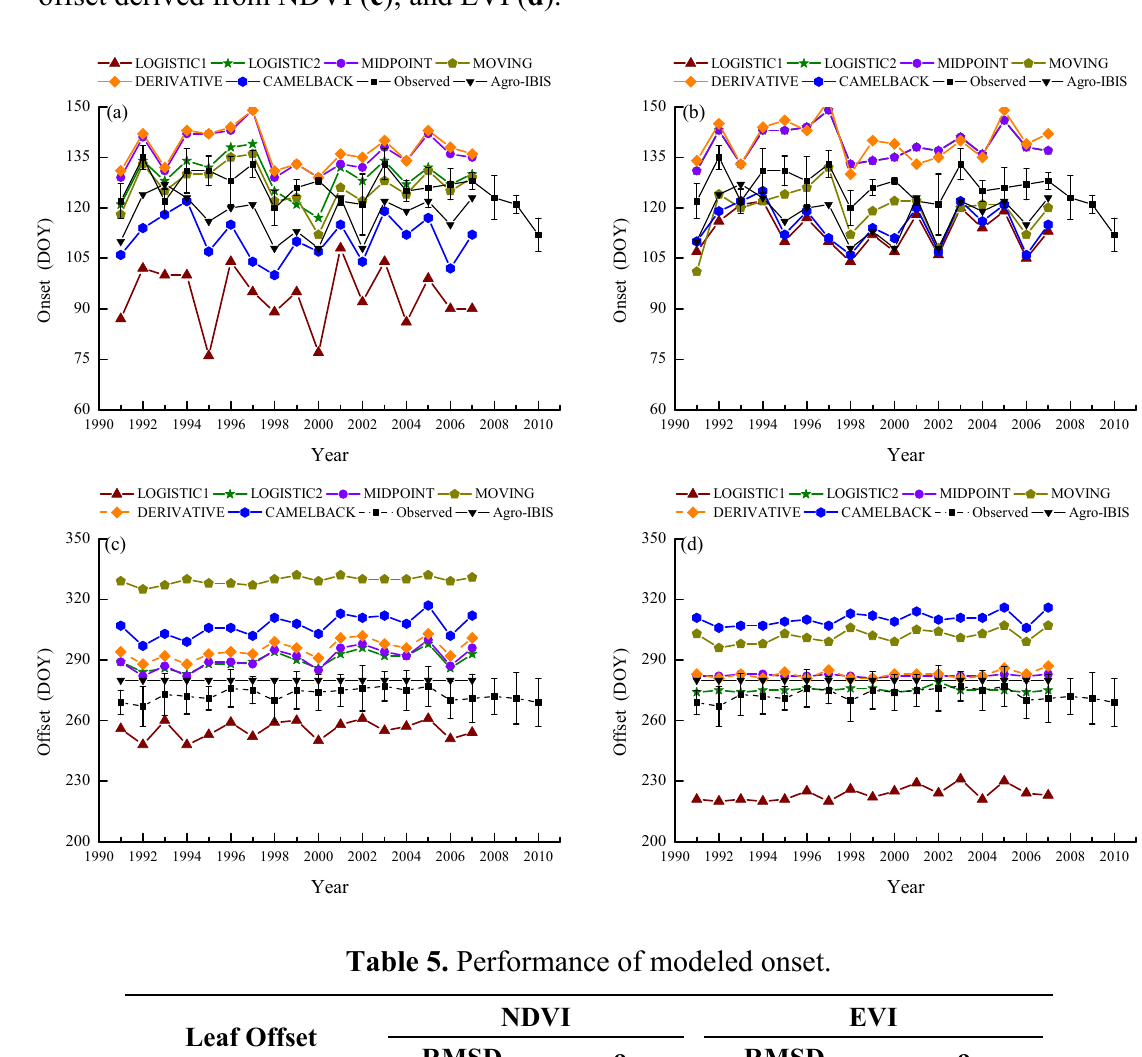
Figure 4. Ground observed and simulated phenology. Error bars indicate the standard deviation of observation. “Agro-IBIS” is the leaf onset or offset simulated using the original Agro-IBIS algorithm and parameters. Onset was simulated using the “Sequential” model and the parameters were optimized with onset derived from NDVI ( a ); and EVI ( b ); offset was simulated using the “Delpierre” model and parameters were optimized with offset derived from NDVI ( c ); and EVI ( d ).